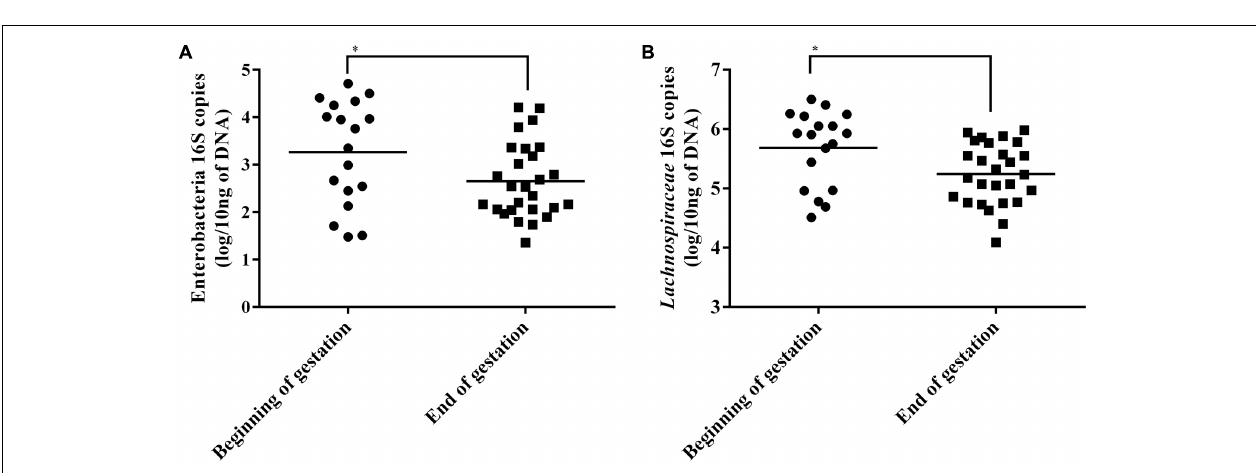
FIGURE 2 | Stacked bar graphs showing the relative abundance at the phylum (A) and family level (B) levels using RDP classification (only taxa representing more than 1% of the sequences) for the four groups of sows. Beginning: Sows in the 50 first days of gestation, End: Sows in the 50 last days of gestation, Negative: Sows not shedding Salmonella , Positive: Sows shedding